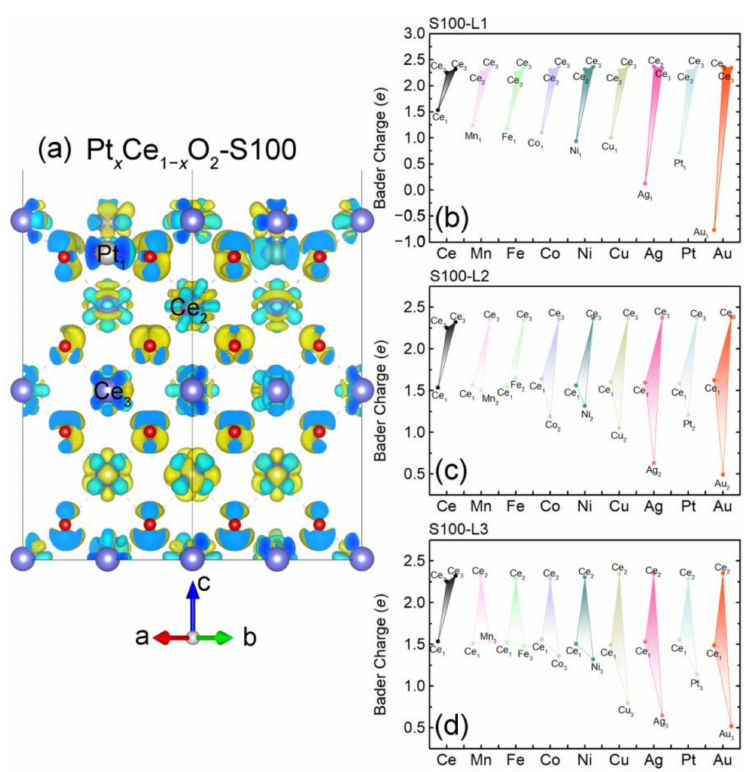
Figure 6. ( a ) The 3D plot of charge density difference with an isosurface value of 0.02 e /Bohr 3 for Pt x Ce 1 − x O 2 -S100 with Pt at L1. ( b – d ) Evolution of Bader charge for M x Ce 1 − x O 2 -S100 with the dependence of Mn, Fe, Co, Ni, Cu, Ag, Pt and Au: ( b ) M in L1, ( c ) M in L2 and ( d ) M in L3, the relevant M site are labeled as M 1 , M 2 and M 3 .